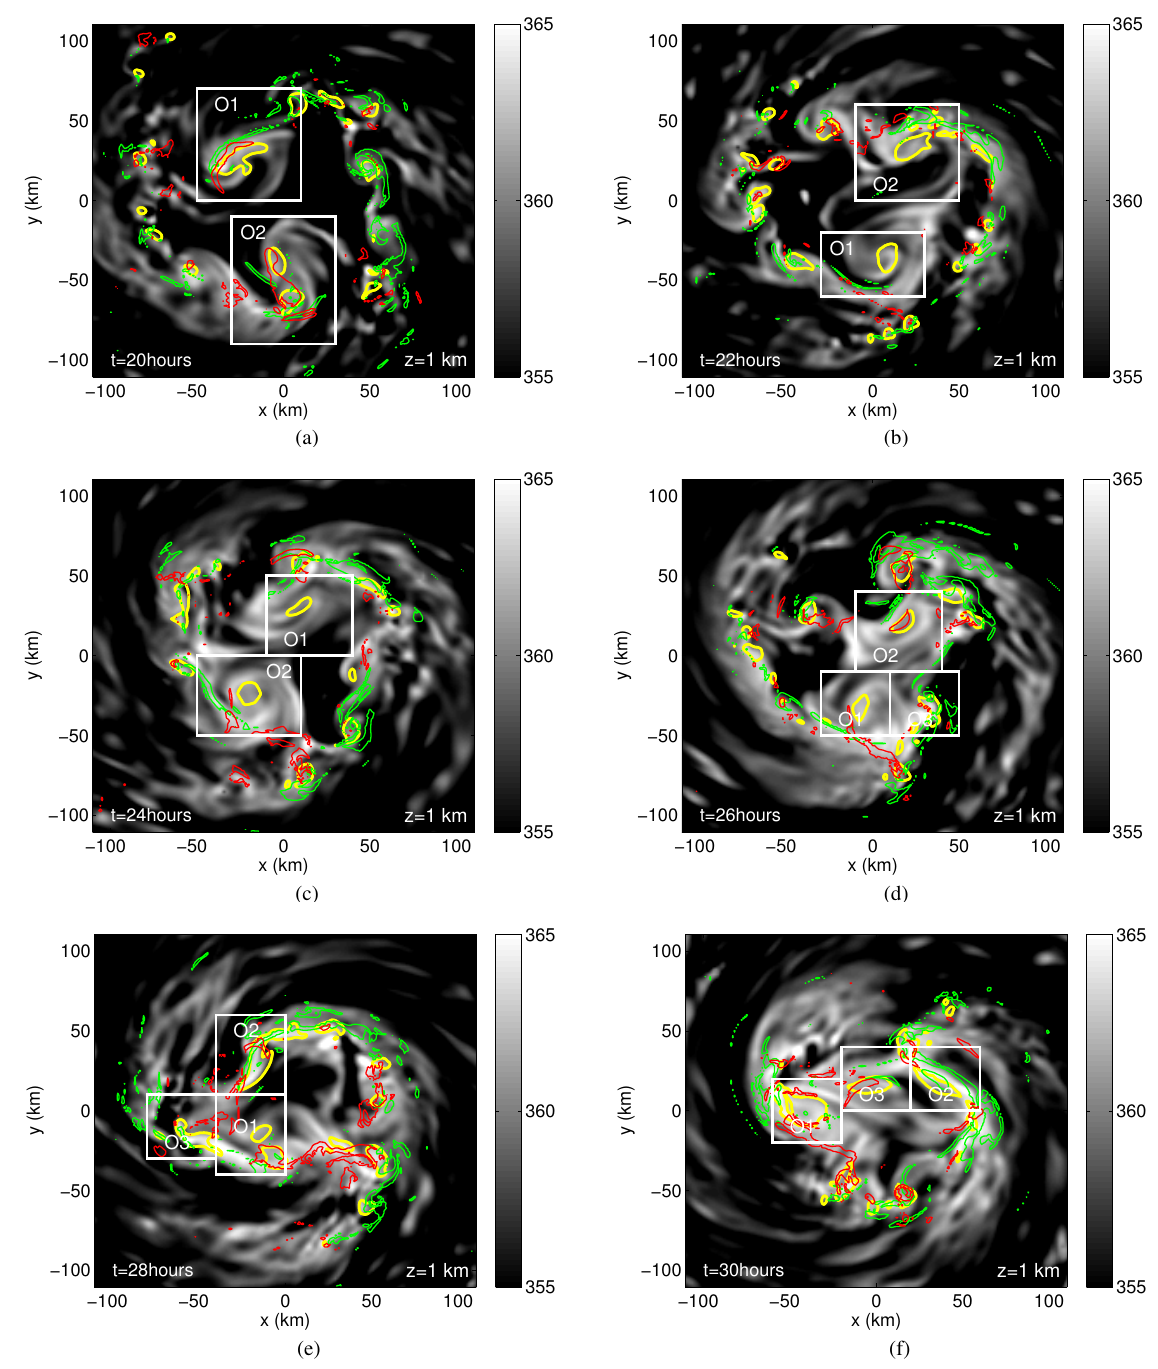
Fig. 15. Mixing regimes can be seen in labeled boxes containing Ψ 22 LCSs at z=1 km with 1 hour integration time at times from 20 hours Fig. 15. Organized mixing regimes can be seen in labeled boxes containing 9 22 LCSs at z = 1km with 1h integration time at times from to 30 hours every 2 hours. The attracting Ψ -LCSs (green), repelling Ψ -LCSs (red), and vorticity contours (yellow) are all overlaid on the θ e 20h to 30h every 2h. The attracting 9 -LCSs (green), repelling 9 -LCSs (red), and vorticity contours (yellow) are all overlaid on the θ e field field (black and white shading). (black and white